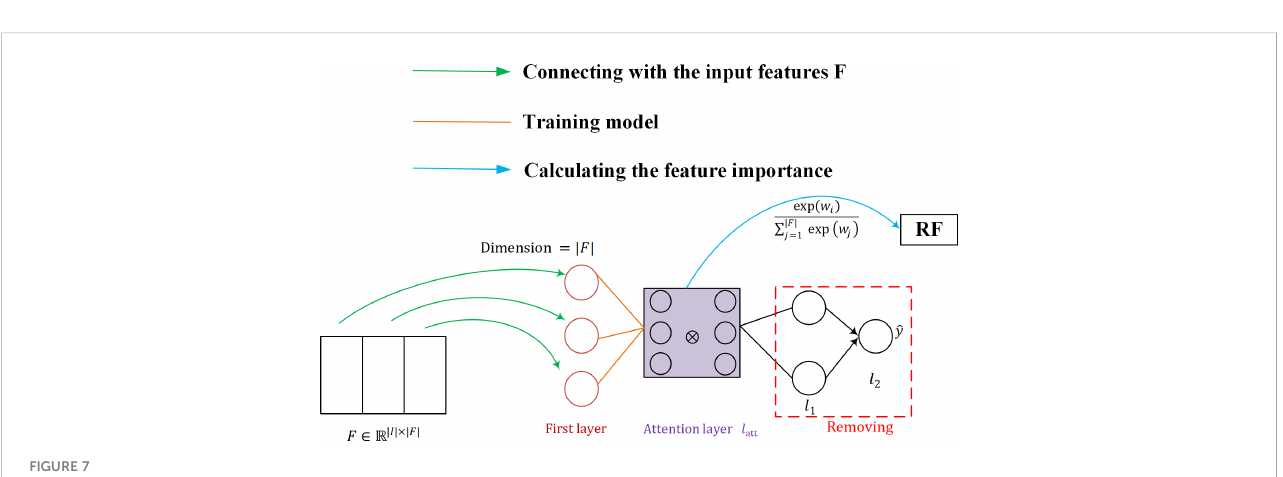
FIGURE 7 Structure of the SARF proposed. RF, Random